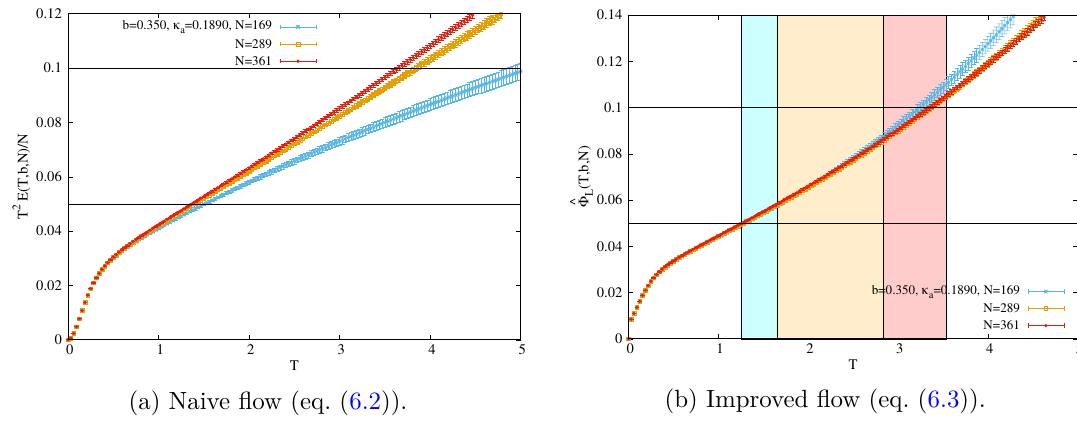
Figure 5. Finite N effects on the dimensionless flowed energy density. The coloured bands in the right plot represent the scaling windows for each value of N , cf. T [1 . 25 , γ 2 N/ 8] , with γ = 0 . 28 . ∈ p window is set by the ratio c ( t ) = 8 T/N , determining the fraction of the box occupied by the smearing radius. An empirical observation is that the correction is efficient over a scaling window given